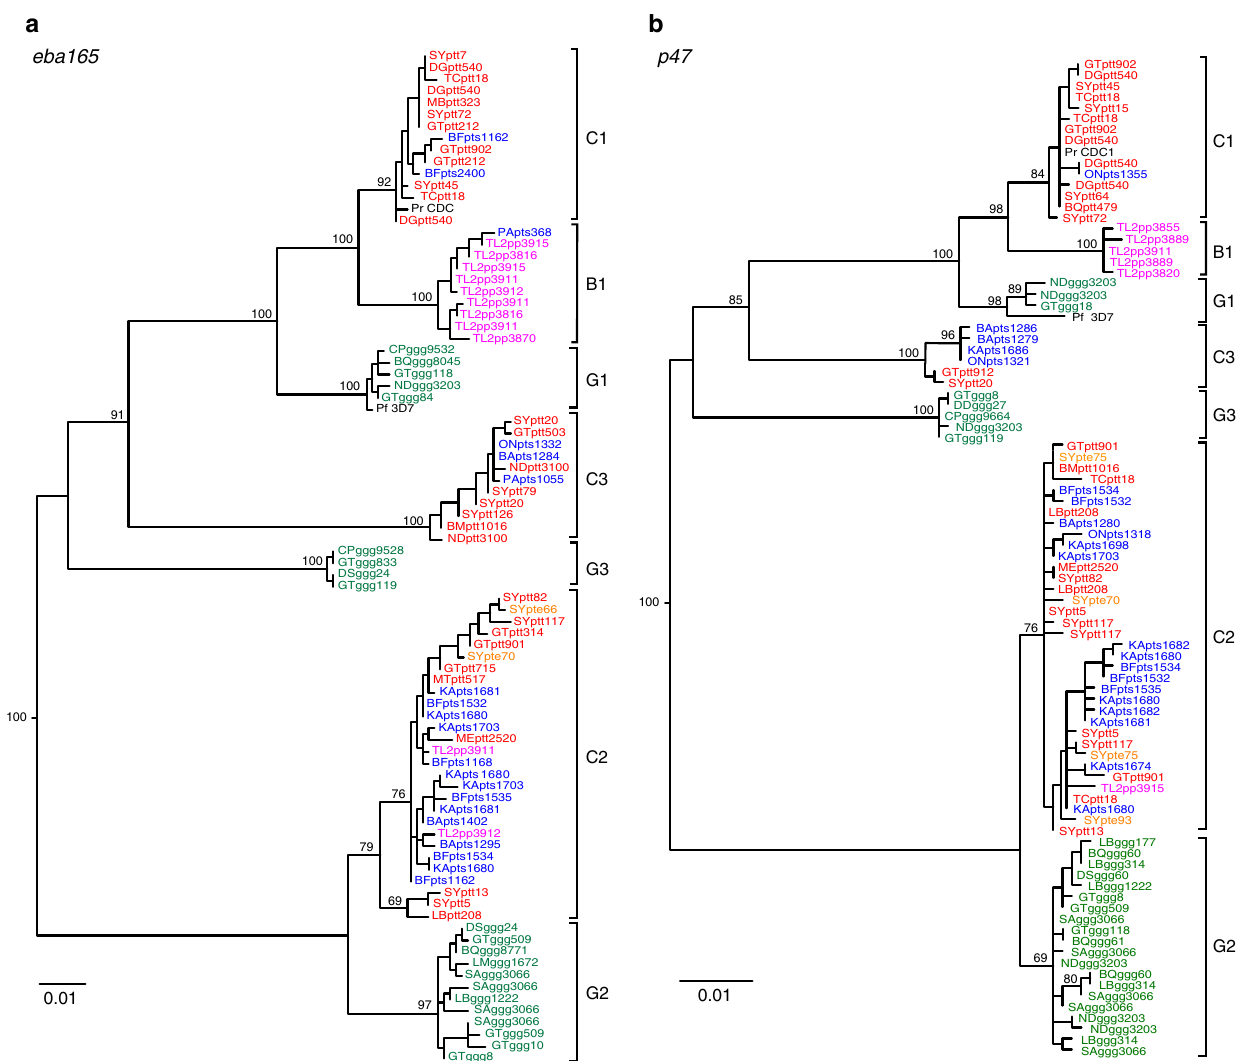
Fig. 3 A new Laverania species speci fi c for bonobos. a , b Maximum likelihood phylogenetic trees are shown for nuclear gene fragments of the a erythrocyte- binding antigen 165 ( eba165; 790 bp) and b the gametocyte surface protein P47 ( p47; 800 bp) of Laverania parasites. Sequences are labelled and coloured as in Fig. 2 (identical sequences from different samples are shown; identical sequences from the same sample are excluded). C1, C2 and C3 represent the chimpanzee parasites P. reichenowi , P. gaboni and P. billcollinsi ; G1, G2 and G3 represent the gorilla parasites P. praefalciparum, P. adleri and P. blacklocki (PrCDC and Pf3D7 reference sequences are shown in black). Bonobo parasite sequences cluster within P. gaboni (C2) or form a new distinct clade (B1), indicating a new Laverania species (see text for information on the single eba165 B1 sequence from an eastern chimpanzee). The trees were constructed using PhyML 58 with TPM3uf+G ( a ) and GTR+G ( b ) as evolutionary models. Bootstrap values are shown for major nodes only (the scale bar represents 0.01 substitutions per